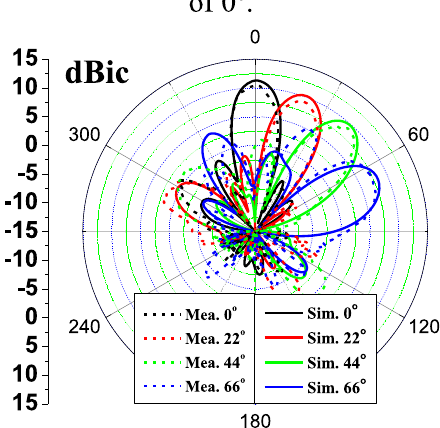
Fig. 17. Structure of proposed MZR CP antenna.